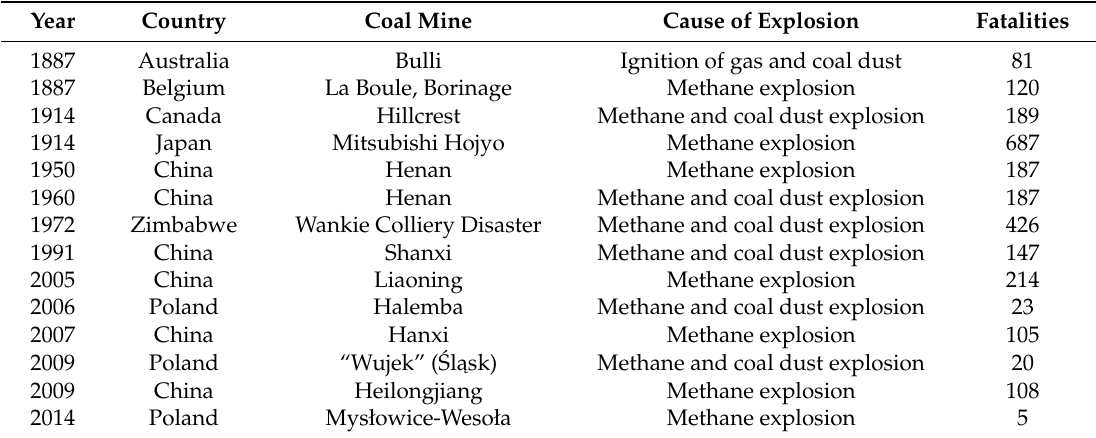
Table 1. Underground coal mine disasters related to methane explosions (examples) [6–8].